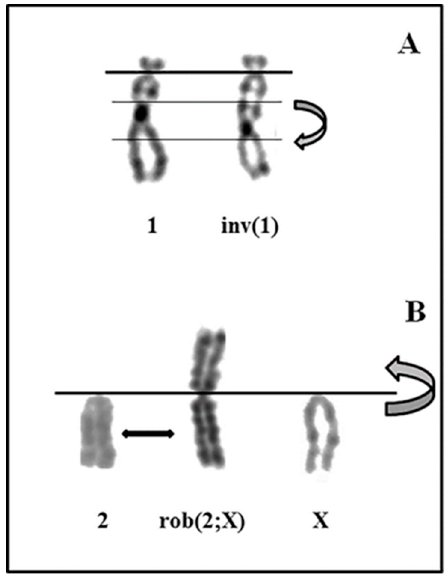
Figure 3. Partial karyotype with reconstruction of two clonal aberrations found in A ‐ VV5. ( A ) Inversion of chromosome #1, ( B ) Robertsonian translocation between chromosomes #2 and #X.